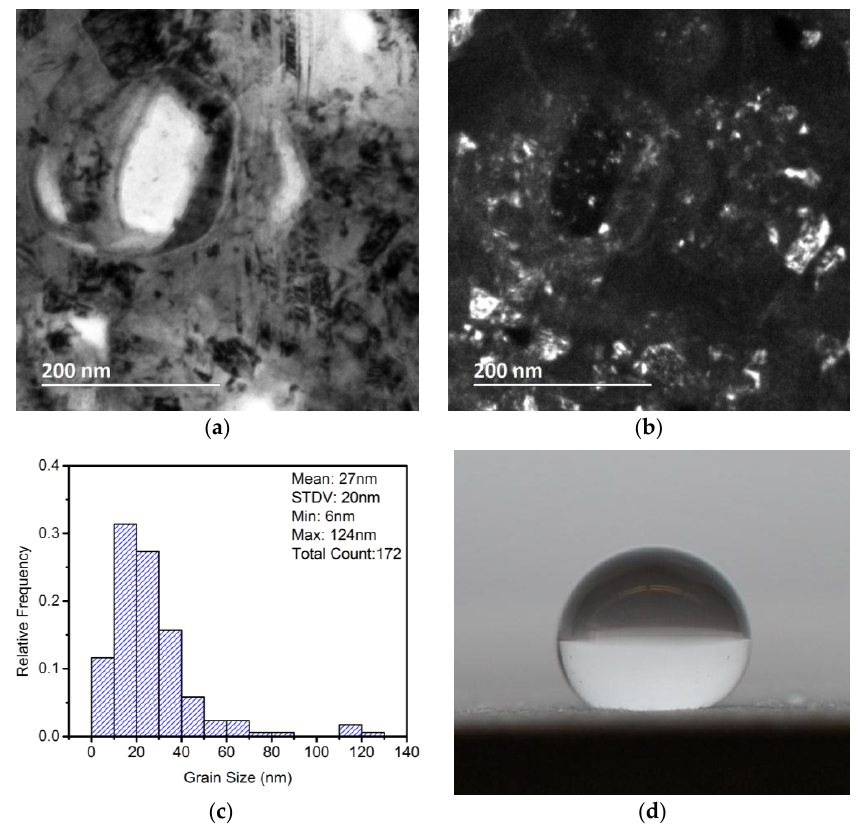
Figure 10. Cross-sectional TEM characterization of nanocrystalline Ni-PTFE composite: ( a ) bright field image; ( b ) dark field image; ( c ) Ni grain size distribution; ( d ) a 5-µL water droplet at rest on nanocrystalline Ni- 70 vol % PTFE coating. Contact angle = 152°.